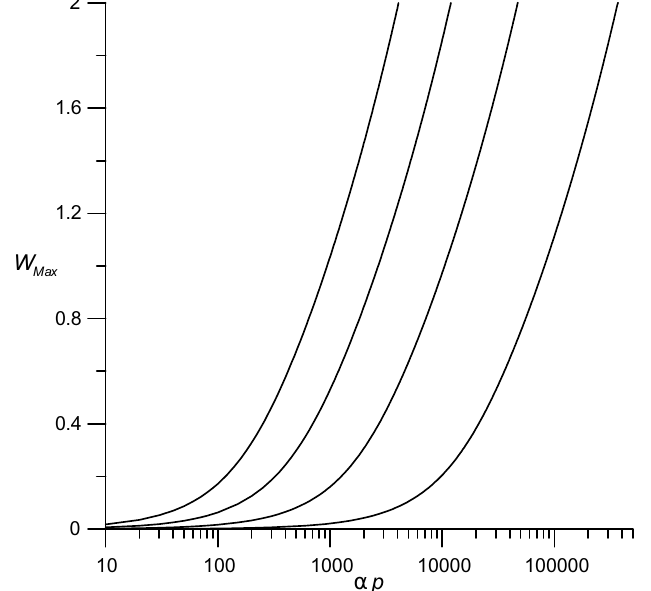
Fig. 2. Variation of the maximum nondimensional deflection W Max with the applied nondimensional load αp for clamped-clamped plates of inner radii b = 0 . 1 , 0 . 3 , 0 . 5 , and 0 . 7 .